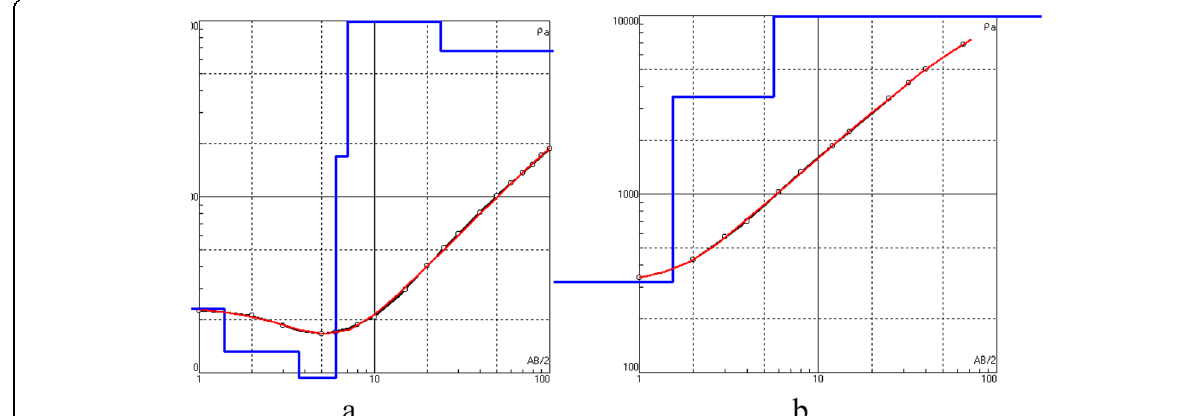
Fig. 16 Selected VES curves for ( a ) cohesive soils ( b ) for cohesionless soils